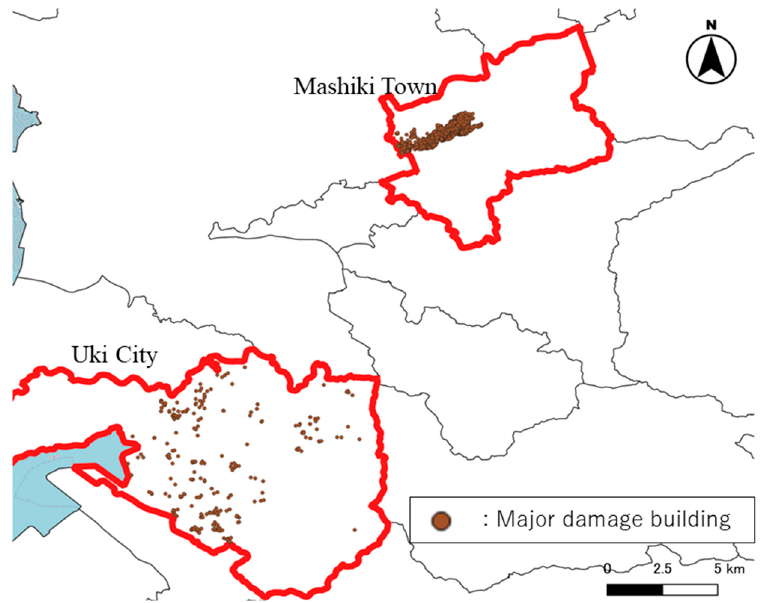
Figure 9. Distribution map of the buildings categorized as Major damage in Mashiki Town and Uki City (brown dots indicate the Major damage buildings).